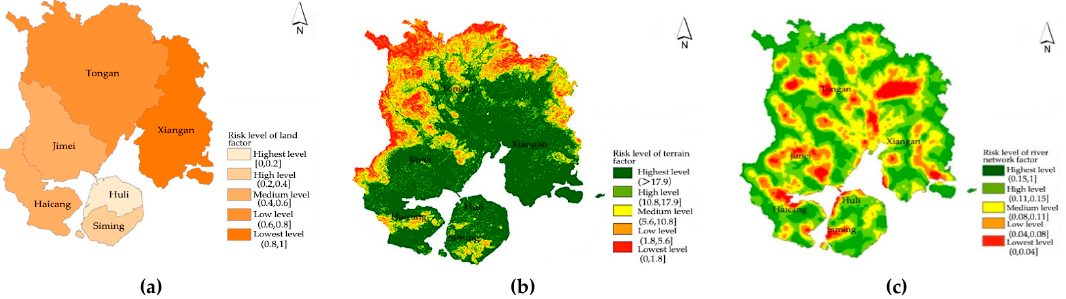
Figure 4. Sensitivity analysis of the environment in Xiamen: ( a ) analysis of land factor; ( b ) analysis of topographic factor; and ( c ) analysis of river network factor. topographic factor; and ( c ) analysis of river network factor.